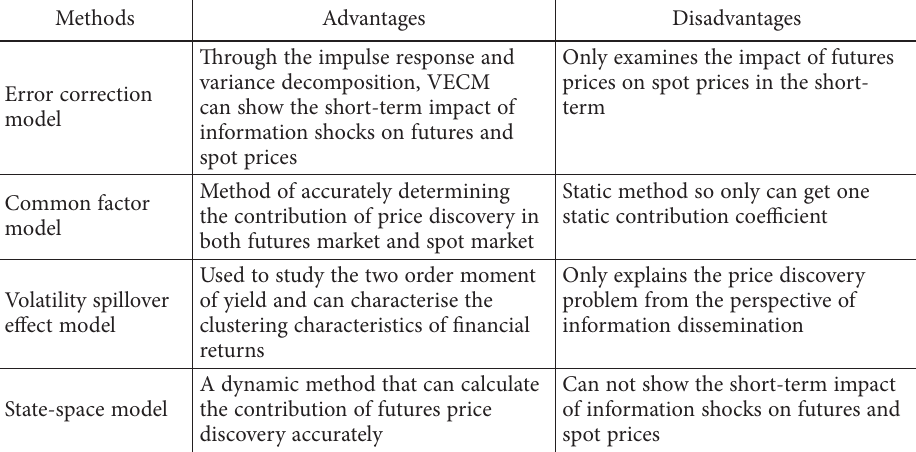
Table 4. Comparison between methods for price discovery function